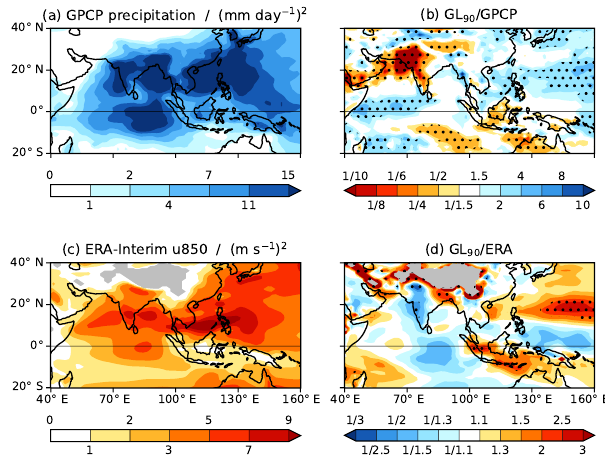
Figure 5. (a) Variance of 24–70-day bandpass-filtered GPCP pre- cipitation for May to October only. (b) Ratio of filtered variance of precipitation from GL 90 to that from GPCP. (c, d) As for pan- els (a, b) but for ERA-Interim u 850, with grey shading used to mask out regions where the 850hPa surface intersects the ground in GL 90 ; stippling indicates 95% statistical significance according to a two-tailed f